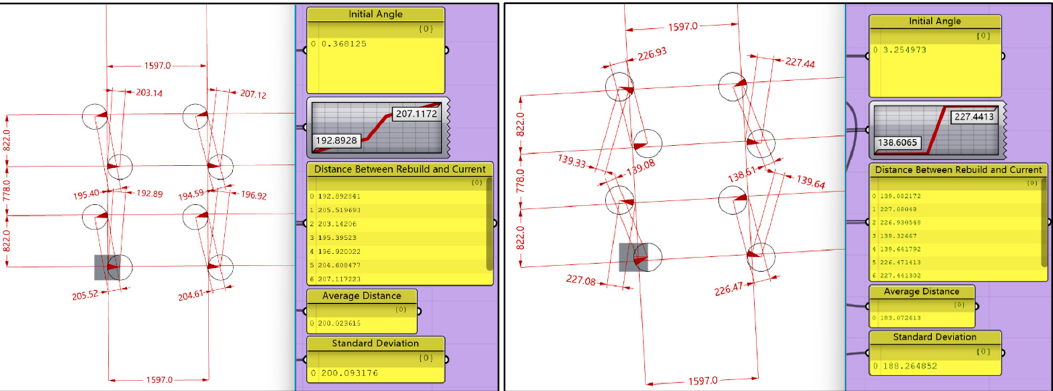
Figure 14. Verification of eight asymmetric columns (the disordered axes on the left, the result axes on the right).